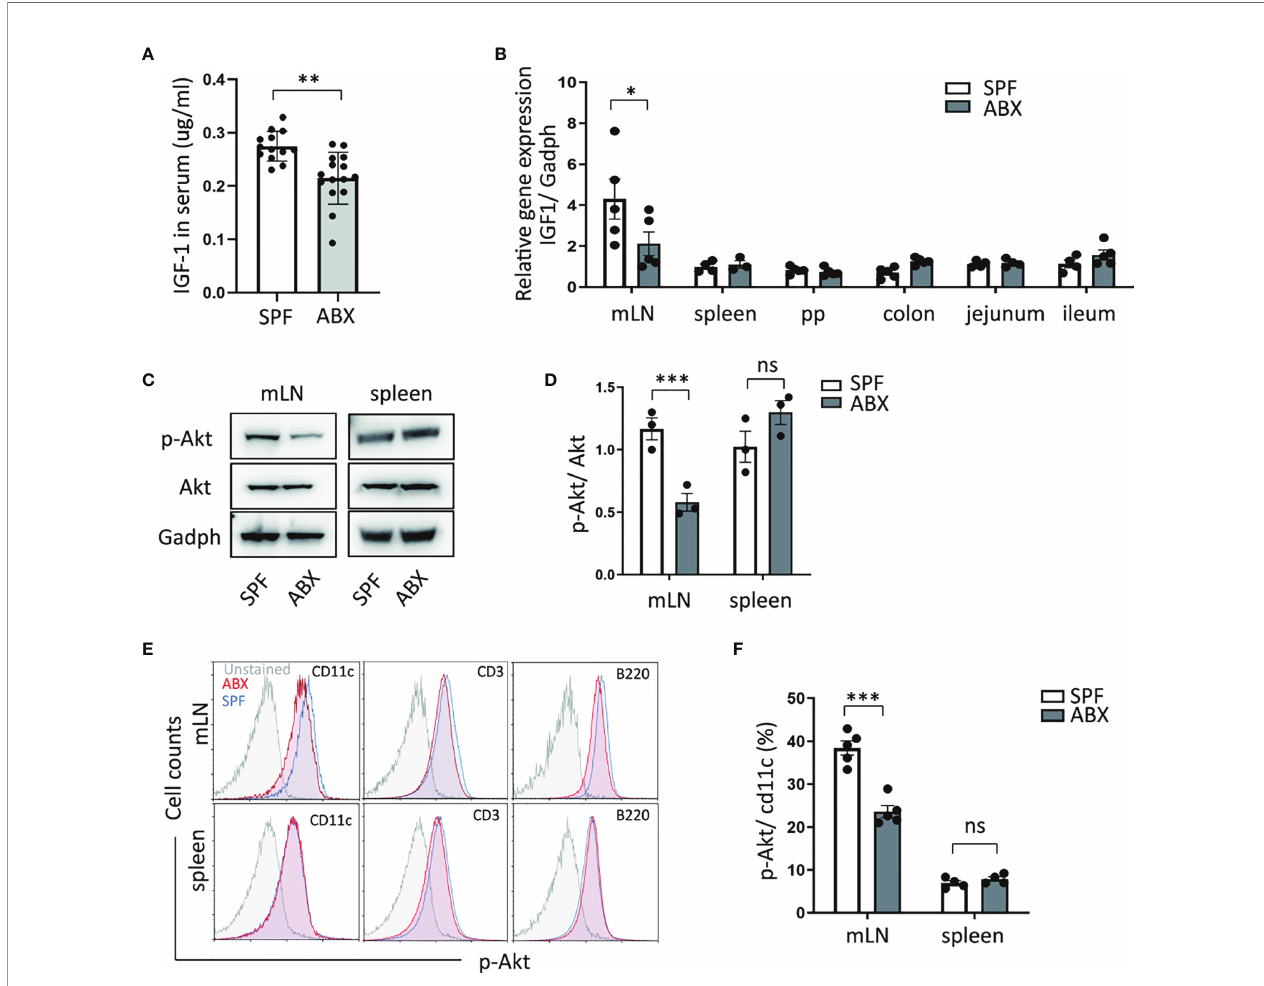
FIGURE 2 | Gut dysbiosis regulates the IGF-1/Akt pathway in mesenteric lymph tissue. (A) After mice treated with ABX, IGF-1 ELISA was performed on serum. (B) And mRNA expression of IGF-1 in mLN, spleen, Peyer ’ s Patches (PP), colon, jejunum, ileum tissues, were measured by RTPCR. (C, D) p-Akt and Akt protein level change in mLN and spleen were determined by western blotting. (E) p-Akt expression levels of DCs (cd11c+), T cells (CD3+), B cells (B220+) in mLN and spleen were measured by fl ow cytometry. (F) Graph shows frequency of p-Akt positive DCs in mLN and spleen. As shown, p-Akt protein level of DC in mLN was reduced in ABX mice. Graph shows mean and SEM. (A) Data are combined from two independent experiments with at least thirteen mice per group. Graph shows mean and SEM. Data were analyzed by unpaired Student ’ s t-test. *p < 0.05, **p < 0.01, ***p < 0.001, ns, not signi fi